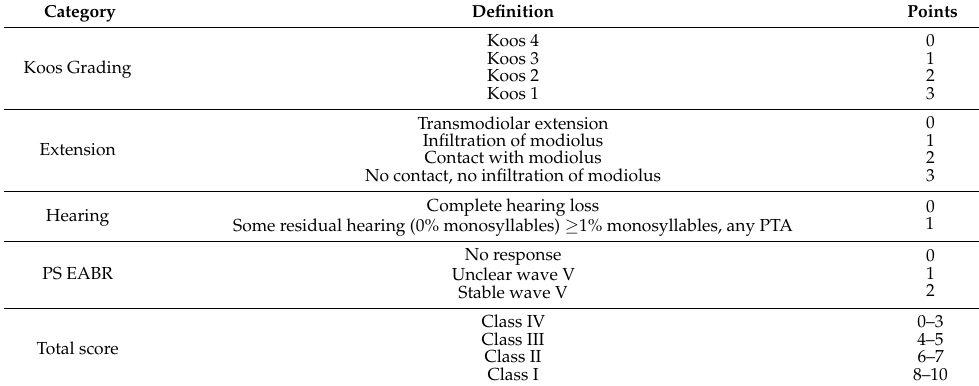
Table 2. Arnoldner et al. score